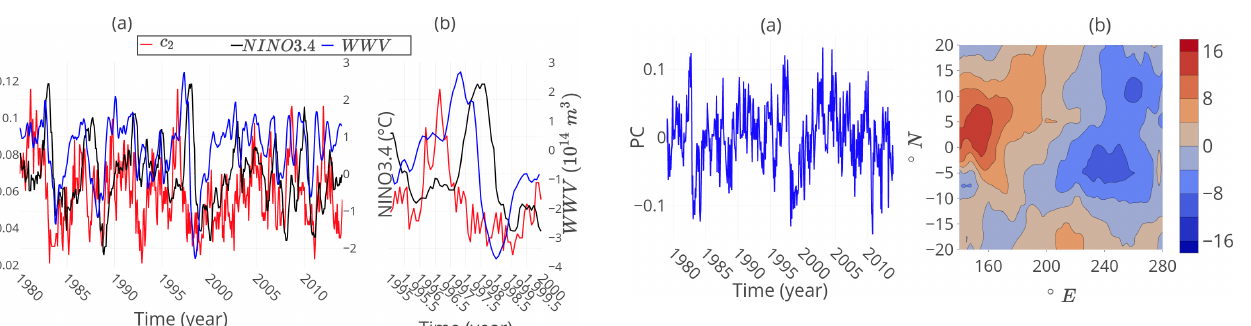
Figure 4. (a) The second principal component of the residual of the wind stress (PC 2 ) and (b) its EOF, associated with the